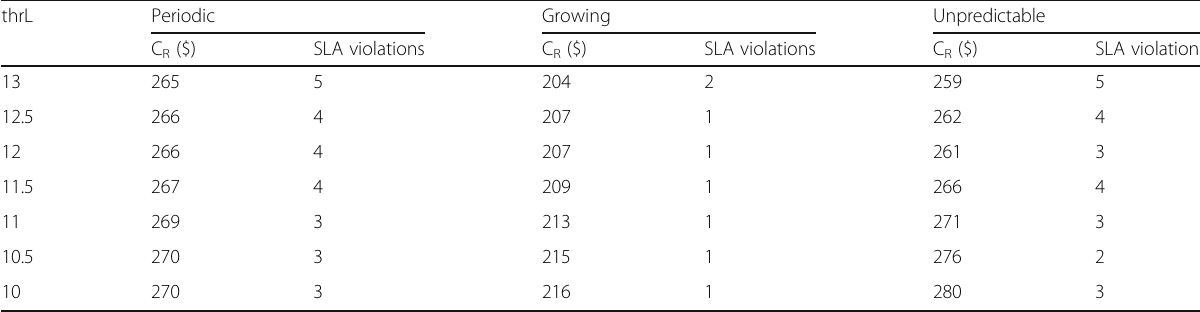
Table 8 Impact of decreasing thrL on the cost factors thrL Periodic